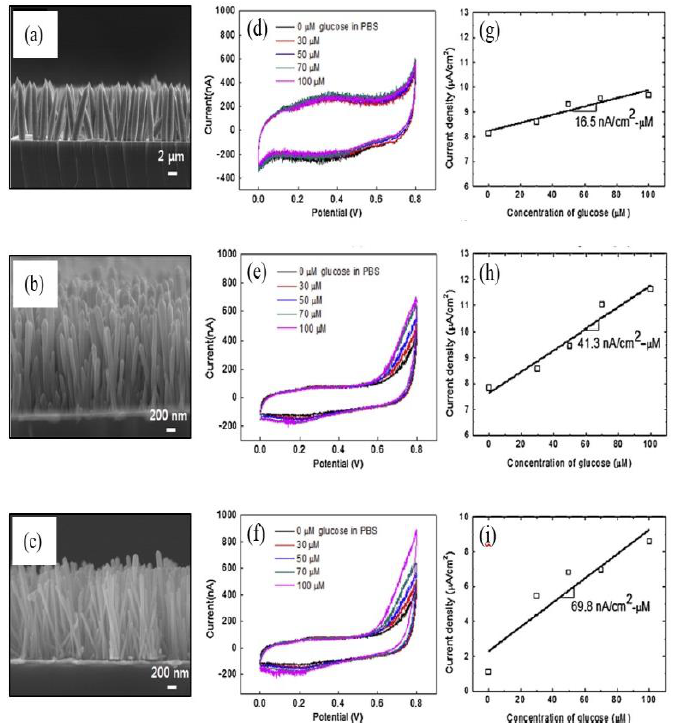
Figure 9. FESEM image of 1-D ZnO ( a ) ZnO-a (Length 7.7 µm; Diameter 1.5 µm); ( b ) ZnO-b (Length 1.58 µm; Diameter 0.105 µm); and ( c ) ZnO-b (Length 1.4 µm; Diameter 0.06 µm). Cyclic voltammograms of the 1-D ZnO amperometric-based glucose sensor ( d ) ZnO-a; ( e ) ZnO-b; and ( f ) ZnO-c. The current density versus glucose concentration ( g ) ZnO-a; ( h ) ZnO-b; and ( i ) ZnO-c. The slopes indicate the sensitivity of the fabricated sensors. Reprinted from Ref. [94]. Copyright 2014, with permission from Elsevier.